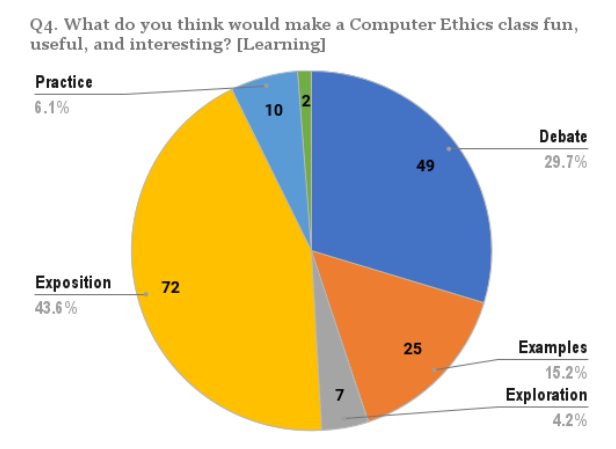
Figure 5. Learning methods preferred by respondents.